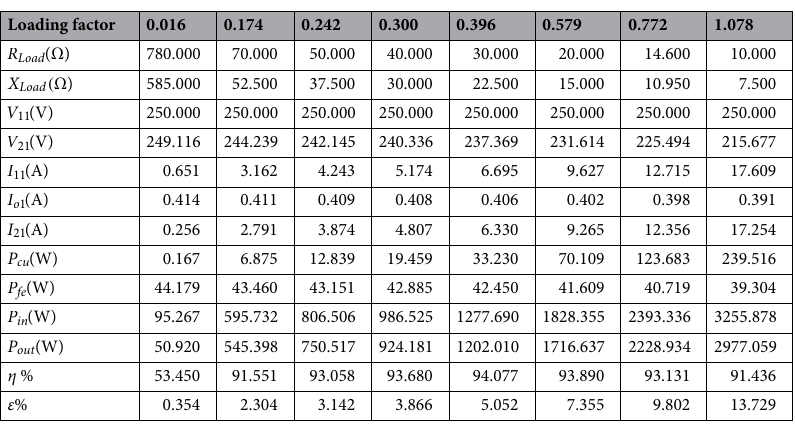
Table 6. Case 2 transformer performance for different loading% at 0.8 lagging PF.